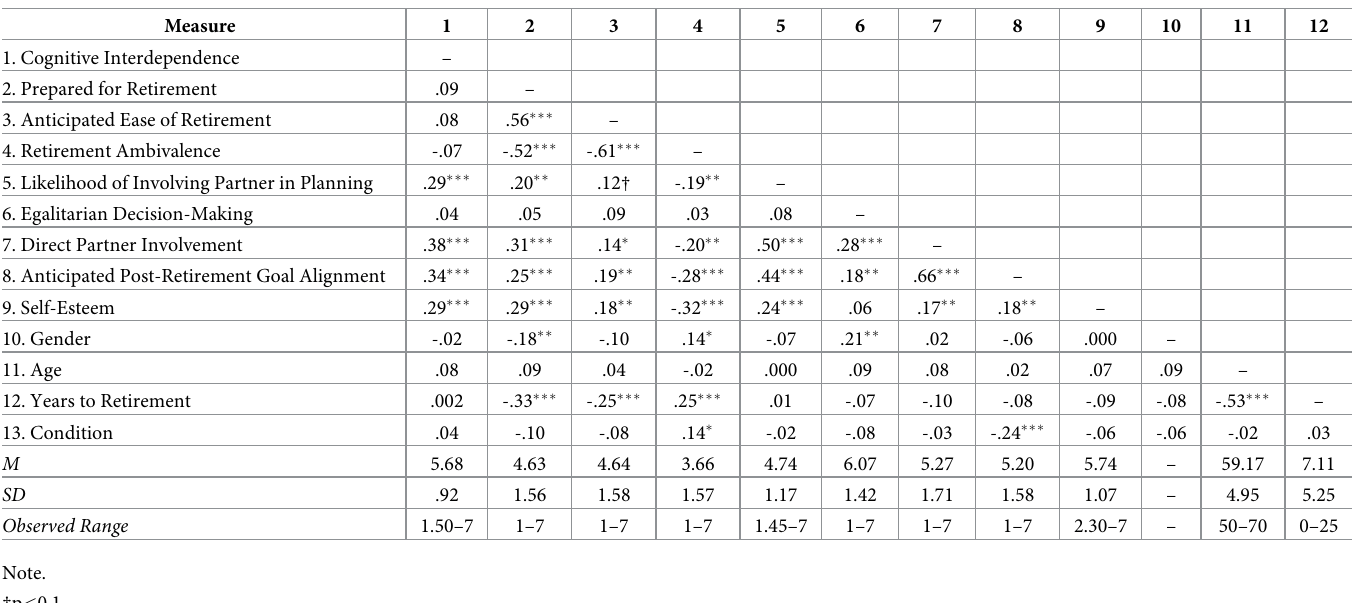
Table 5. Study 3 correlations and descriptive